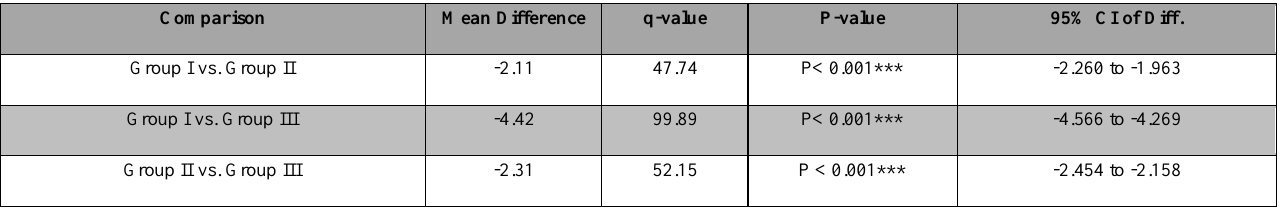
Table 4. Comparison of the difference in mean shear bond strength between groups by Tukey